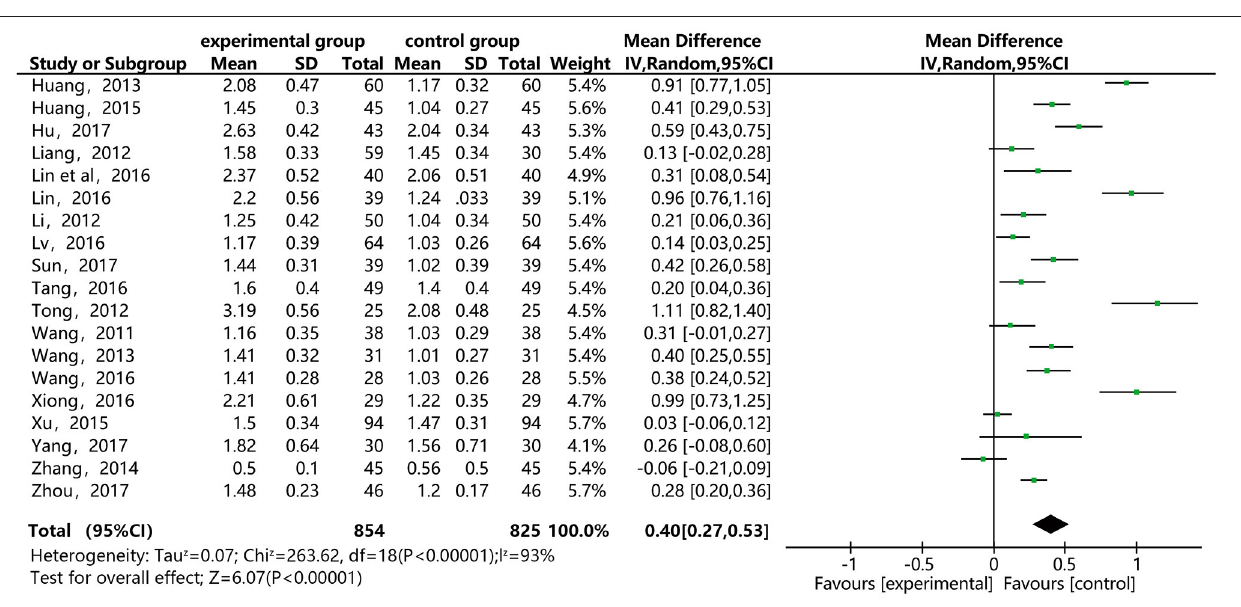
FIGURE 6 | Meta-analysis forest map for of the effect of DSP combined with aspirin on HDL-C in patients with